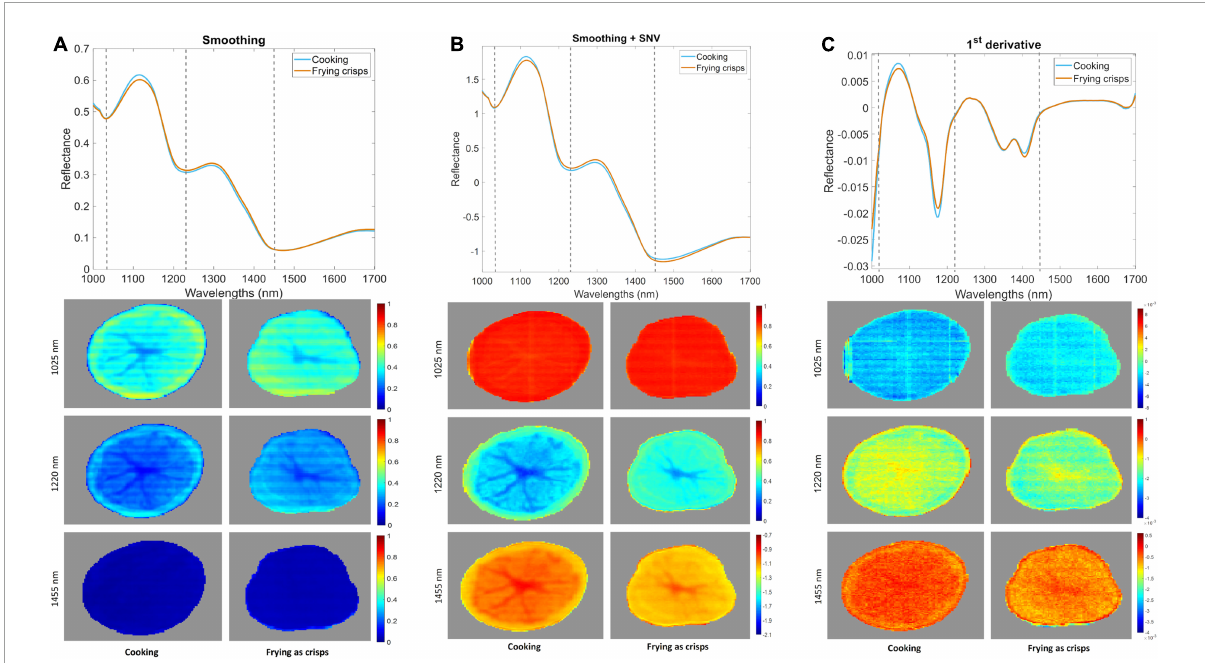
FIGURE3 Influence in the visualization of samples of different pre-processing techniques: smoothing (A) , smoothing + SNV (B) and 1st derivative (C) at three specific wavelengths (1,025, 1,220, and 1,455